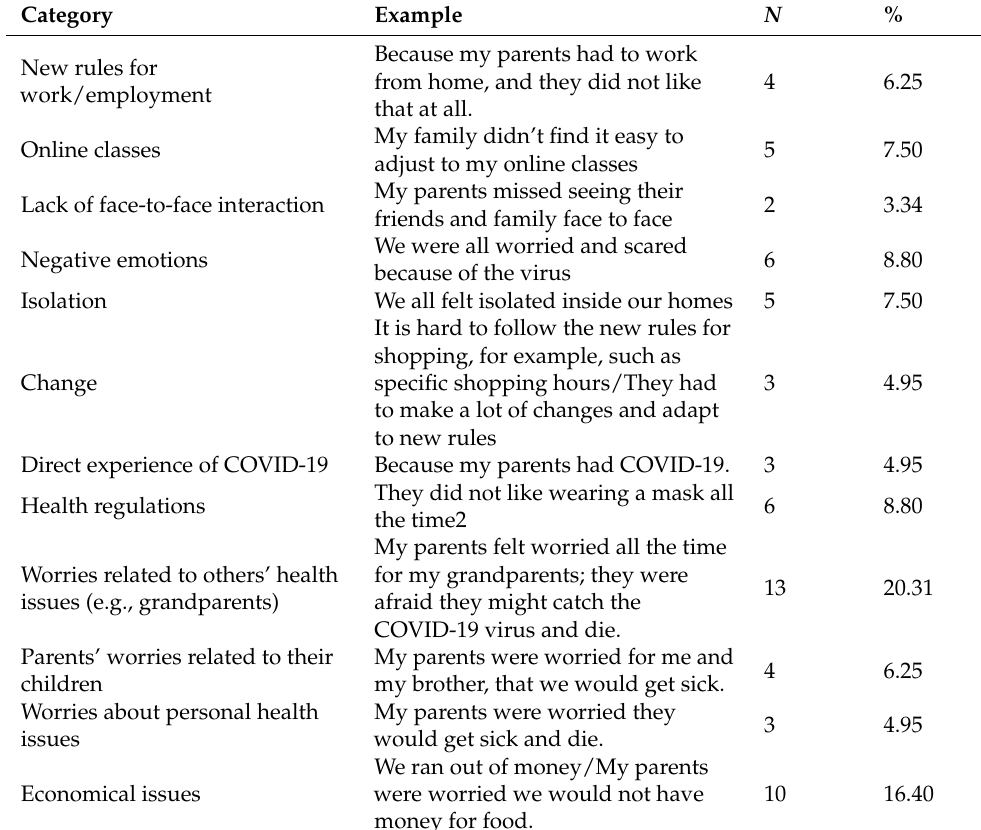
Table 4. Source of others’ perceived adverse effects of the COVID-19